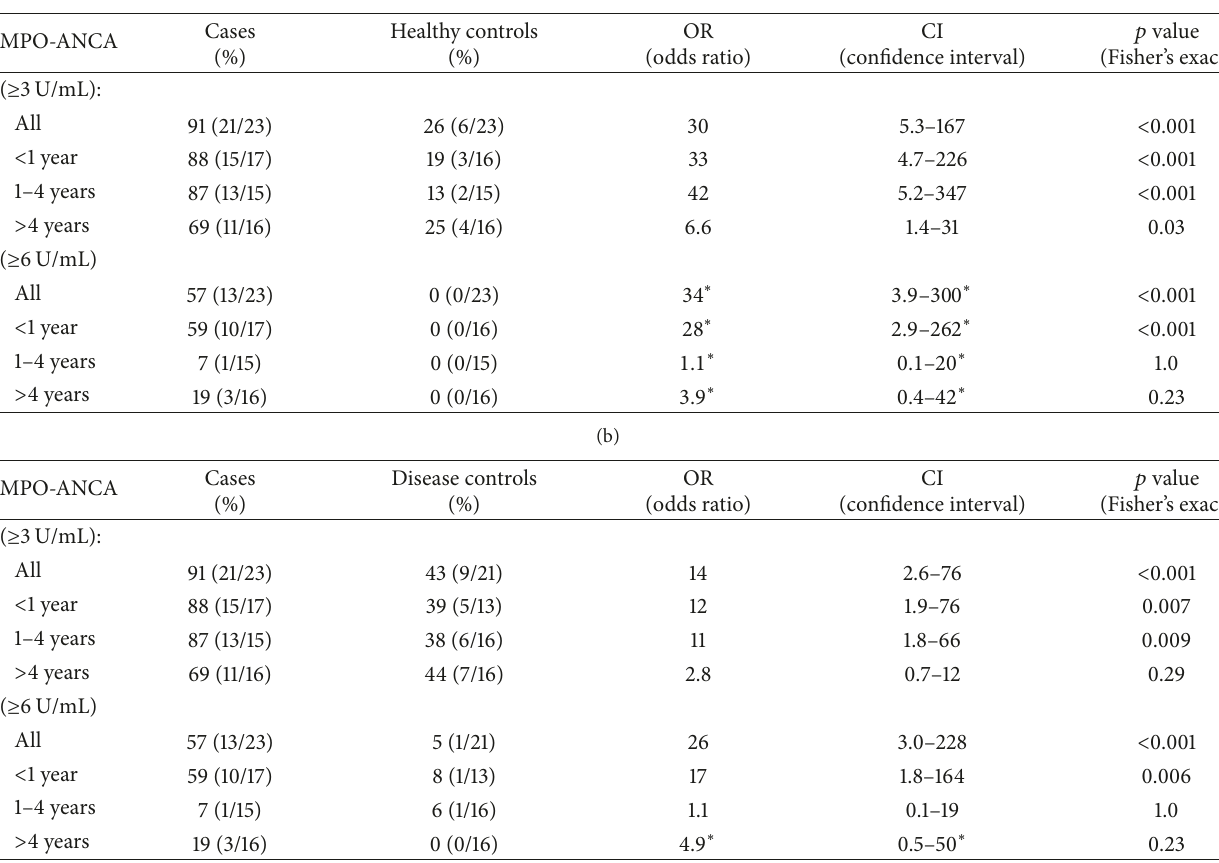
Table 2: The percent PLN patients with MPO-ANCA above specific thresholds compared to matching healthy and SLE without LN disease controls. The Department of Defense Serum Repository could not assign a matching disease control for one patient. The samples for a second control were lost in processing. Not all patients had samples available for each subgroup time period. If multiple serum samples were present for a patient in a specific subgroup analysis time period, the highest antibody level dictated group assignment. ∗ Estimated due to actual infinite